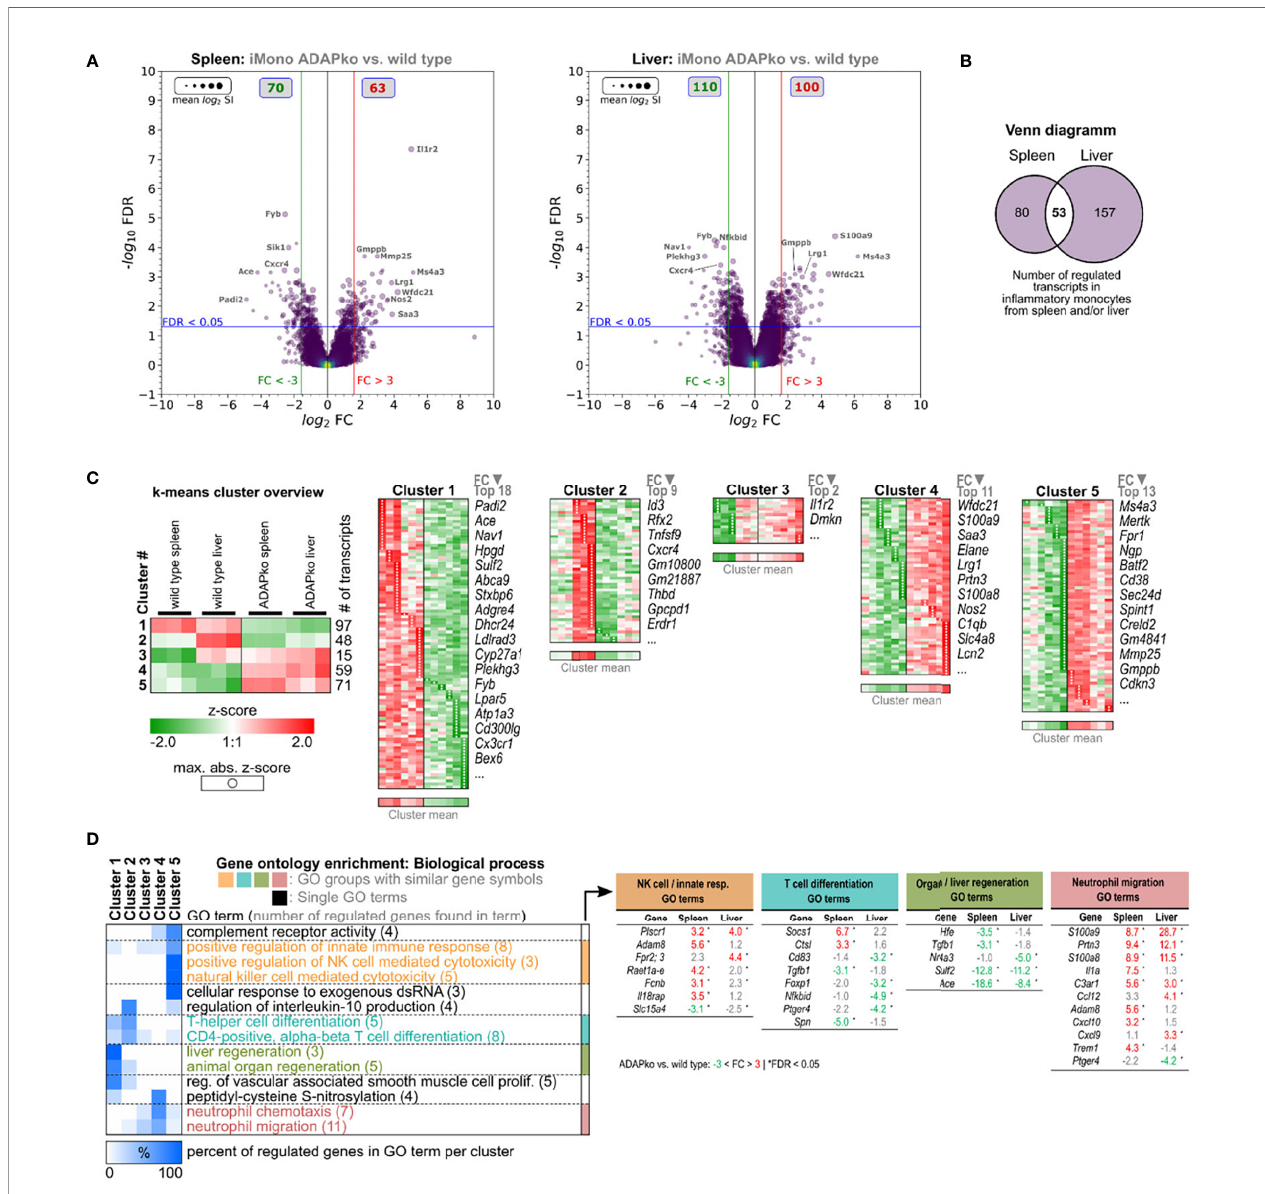
FIGURE 5 | Microarray analysis of in fl ammatory monocytes from the spleen and liver of wild type and ADAPko mice 3 days post in vivo Listeria monocytogenes ( Lm ) infection. Wild type and ADAPko mice (age: 9 – 15 weeks) were infected i.v. with 2.5 × 10 4 CFU Lm (strain 10403S) and sacri fi ced on day 3 post infection. In fl ammatory monocytes (Ly6G − CD11b + CX3CR1 low Ly6C high cells) were FACS-sorted from the spleen and liver. Per genotype and organ, in fl ammatory monocytes from six mice were isolated; and cells from two mice were pooled, resulting in n = 3 independent replicate sample pools per organ and genotype. Total RNA was isolated and analyzed by Clariom S microarray (23 samples in total). Differentially expressed transcripts in spleen-/liver-derived in fl ammatory monocytes were determined comparing ADAPko versus wild type condition (fold change > ± 3-fold, FDR < 0.05). (A) Volcano plots of validly detected transcripts from indicated microarray comparisons, plotting − log 10 FDR versus log 2 fold change. Point sizes refer to mean log 2 signal intensities (SIs) of transcripts calculated across all microarrays. Point color code re fl ects point density. FC (red/green vertical lines) and FDR (blue horizontal lines) criteria for differential gene expression are indicated. Gray boxes show numbers of signi fi cantly upregulated (red) and downregulated (green) transcripts. Gene symbols of selected transcripts are stated. (B) Venn diagram of 604 transcripts, differentially regulated in in fl ammatory monocytes isolated from the spleen or liver comparing ADAPko versus wild type condition, respectively. (C) Log 2 SI data of the 604 transcripts were z-score transformed and k-means clustered (k = 5), and transcripts in resulting clusters were descendingly sorted by maximal absolute z-score (marked by black point indicators). Data represent color-coded z-scores. Stated gene symbols in each cluster are descendingly ranked by average absolute FC, showing the top n symbols. Top left sub fi gure: averaged representation of k-means clusters. Sample type, cluster ID, and numbers of genes per cluster are indicated. (D) Gene Ontology (GO) enrichment analysis for GO category “ Biological Process ” (FDR < 0.05, GO level ≥ 8). GO term groups with the highest signi fi cance and numbers of overrepresented genes for ADAPko versus wild type are shown. Data represent hierarchically clustered percentages of enriched genes (color code) that fall into indicated k-means clusters. Numbers in brackets represent number of enriched genes per GO term. ADAPko, adhesion and degranulation-promoting adaptor protein knockout; CFU, colony-forming units; FACS, fl uorescence-activated cell sorting; FDR, false discovery rate; FC, fold